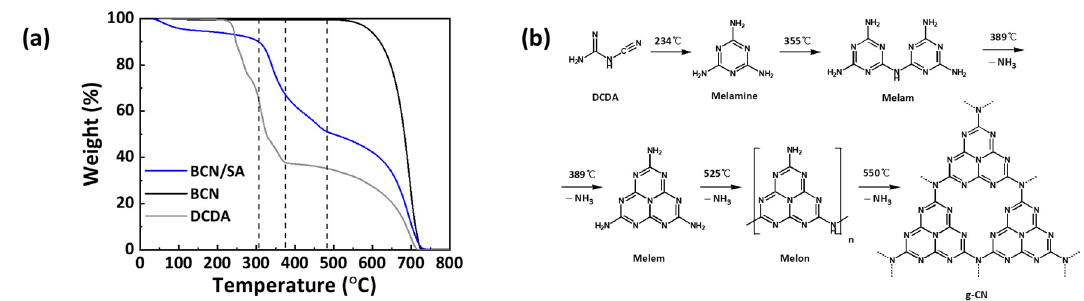
Figure 4. Thermal gravimetric analysis (TGA) of dicyandiamide (DCDA), BCN, BCN/SA ( a ) and schematic diagram of polymerization of DCDA to g-CN ( b ) [26].